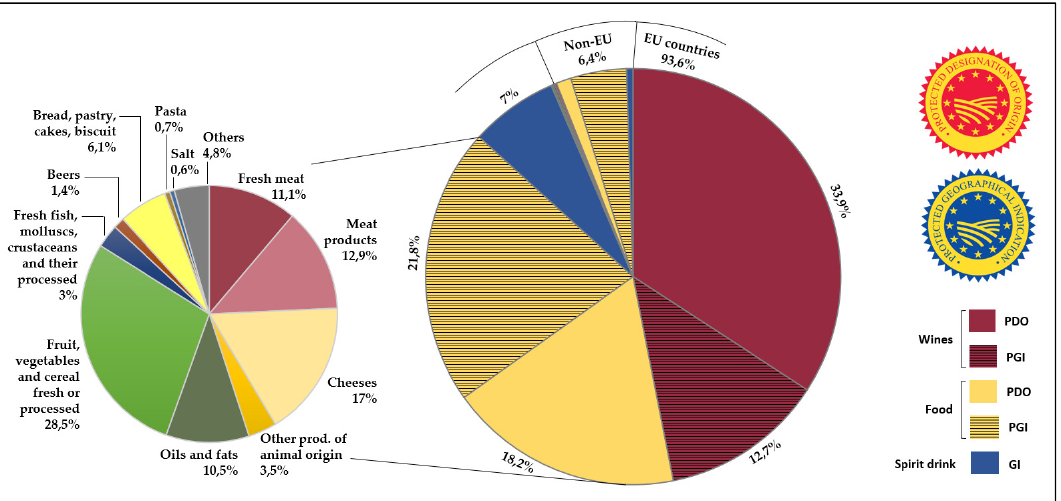
Figure 4. Percentage significance of differentiated quality products protected in the EU by geo- graphical indication, category, and registration subcategories. Source: Data from the European Commission. eAmbrosia, EU Register of Geographical Indications (last consulted in January 2022). Own elaboration.